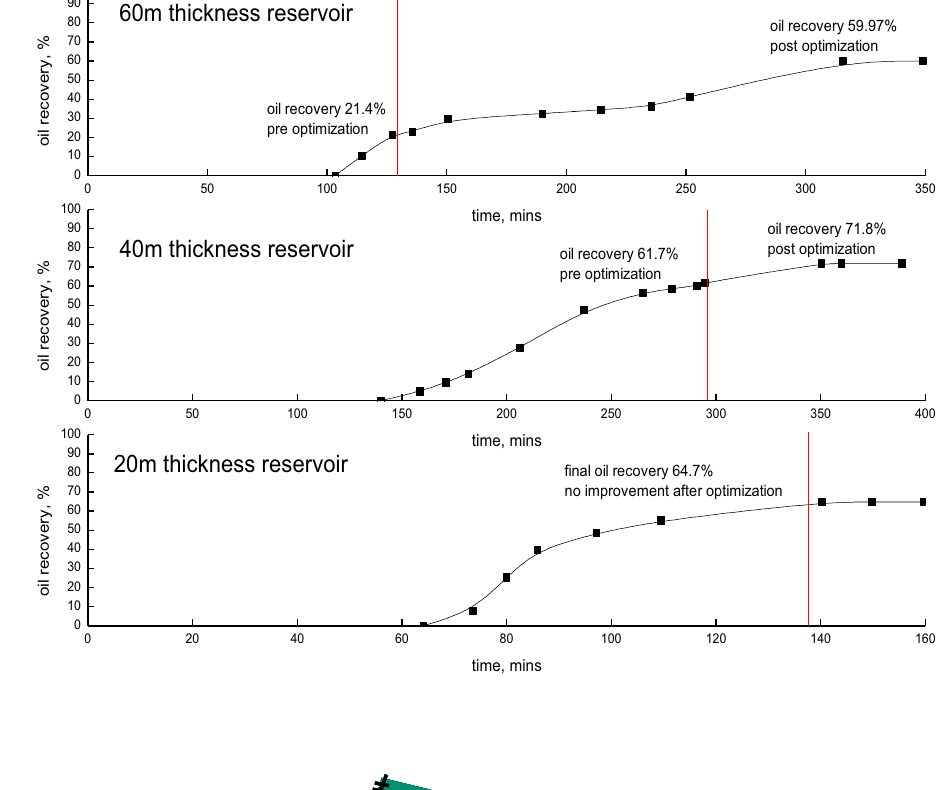
Fig. 10 The oil recovery comparison pre- and post- optimization in 20-m, 40-m and 60-m reservoirs